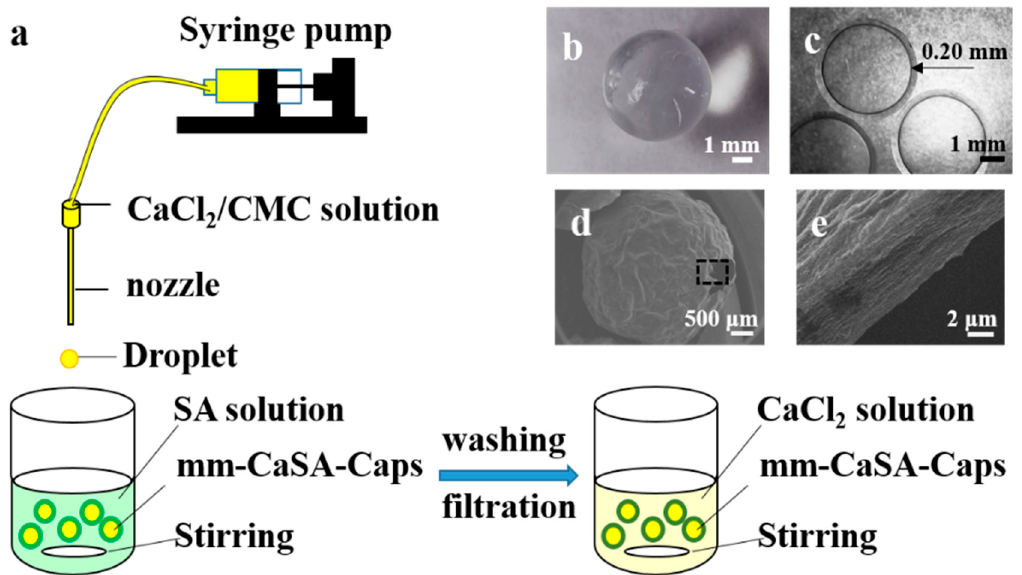
Figure 1. ( a ) Schematic drawing of the preparation process of millimeter-scale calcium sodium alginate capsules (mm-CaSA-Caps); ( b ) mm-CaSA-Caps (top view); ( c ) microscope image of the mm-CaSA-Caps (in water); ( d ) SEM image of the mm-CaSA-Caps (after freeze drying) and ( e ) high magnification of the rectangular part in ( d ).